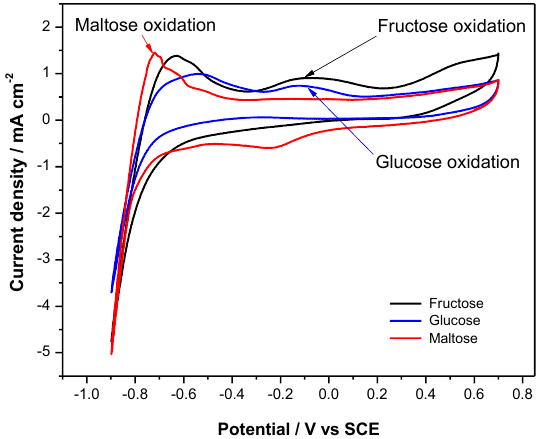
Figure 2. Cyclic voltammograms of PtRu/C on a glassy carbon electrode in the presence of fructose, glucose, and maltose in 0.3 M KOH, the scan rate of 20 mVs − 1 at room temperature at the concentration (cid:13) corresponding to 7up R